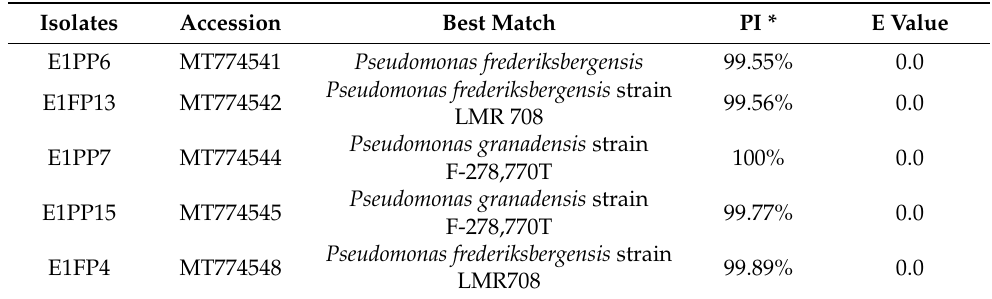
Table 5. BLAST results of selected Pseudomonas